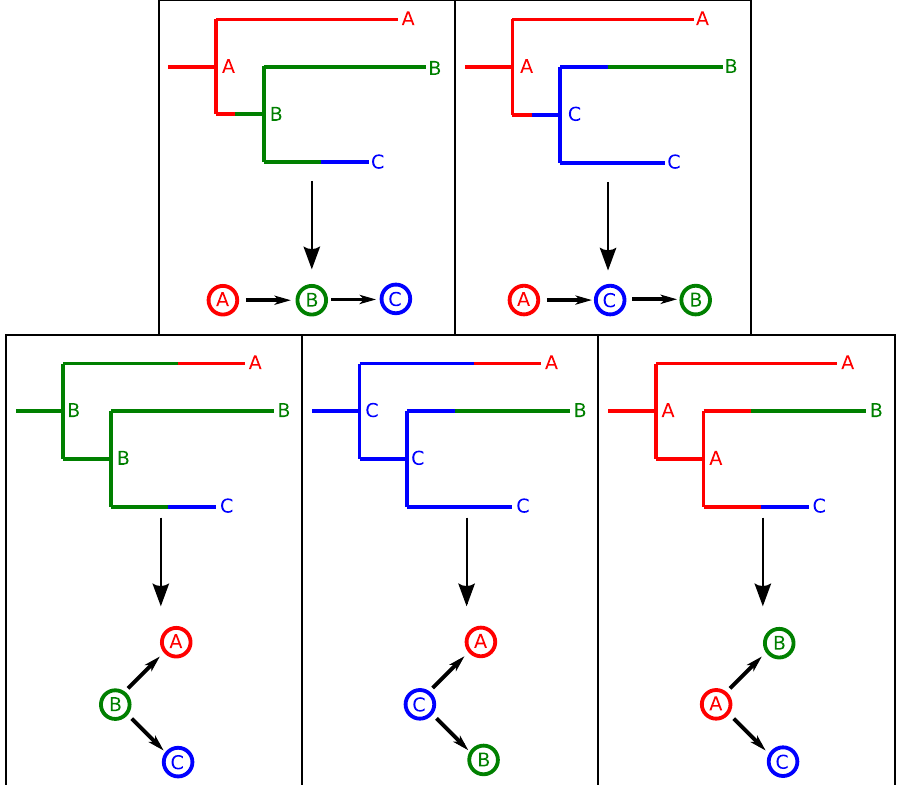
Fig 1. The five possible transmission tree structures of a phylogenetic tree with three tips, depicted as partitions of the nodes of a phylogeny (above) and as directed graphs amongst the hosts A, B and C